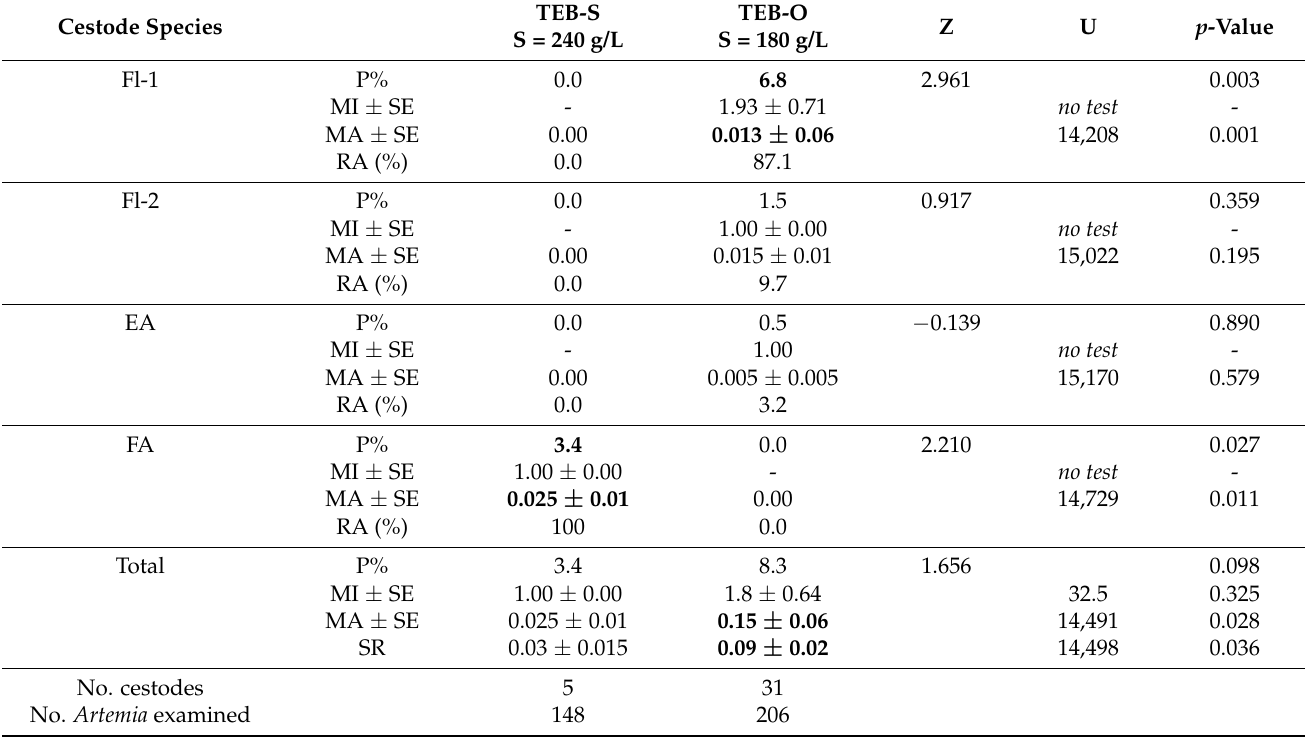
Table 4. Cestode infections in relation to high salinity in A. franciscana samples from Tebenquiche lagoon, Salar de Atacama (Northern Chile), collected in austral autumn (02 June 2018). Abbreviations corresponding to cestode species are explained in the text. P%, prevalence; MI, mean intensity; MA, mean abundance; SE, standard error; RA (%), relative abundance; SR, species richness. Z test and Mann–Whitney U test were used for comparing infective parameters. Significantly higher values are in